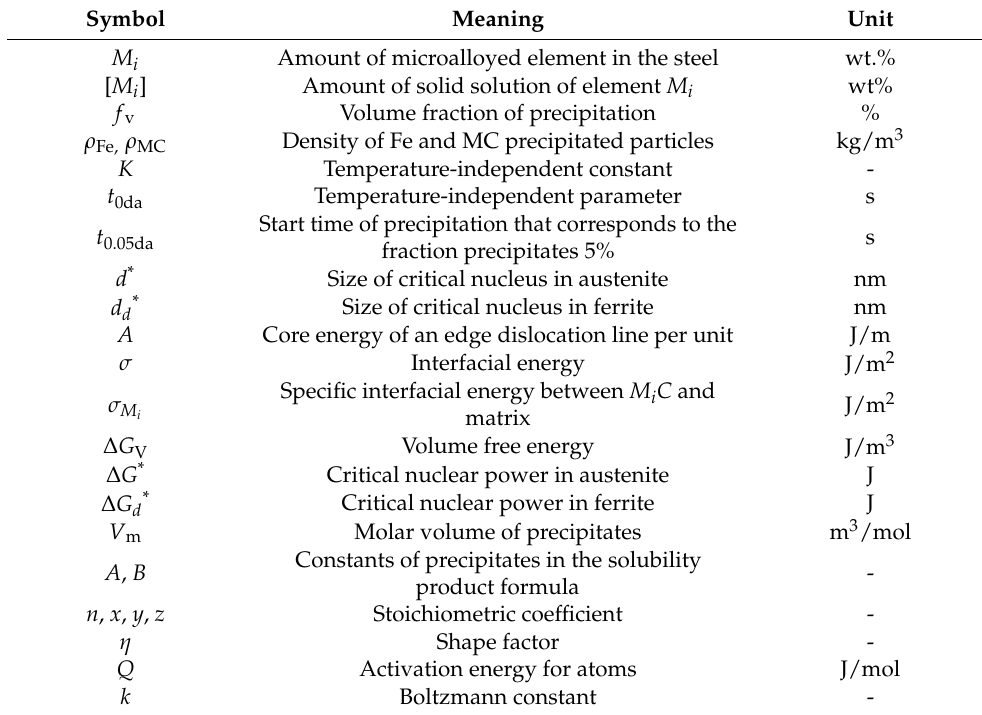
Table 2. Meanings and units of different symbols.